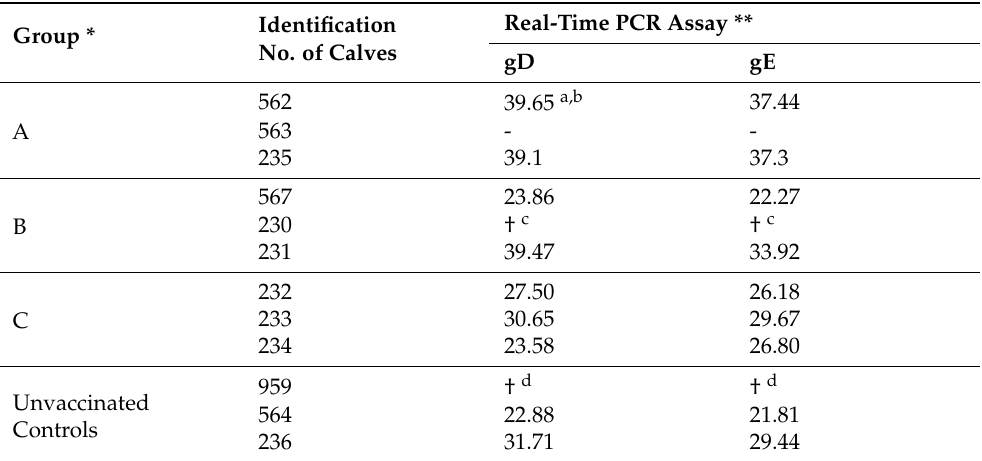
Table 4. Results of BoHV-1 detection using gD and gE real-time PCR of calves immunized with different BoHV-1 marker vaccines, challenge infected with virulent strain of BoHV-1, and treated with